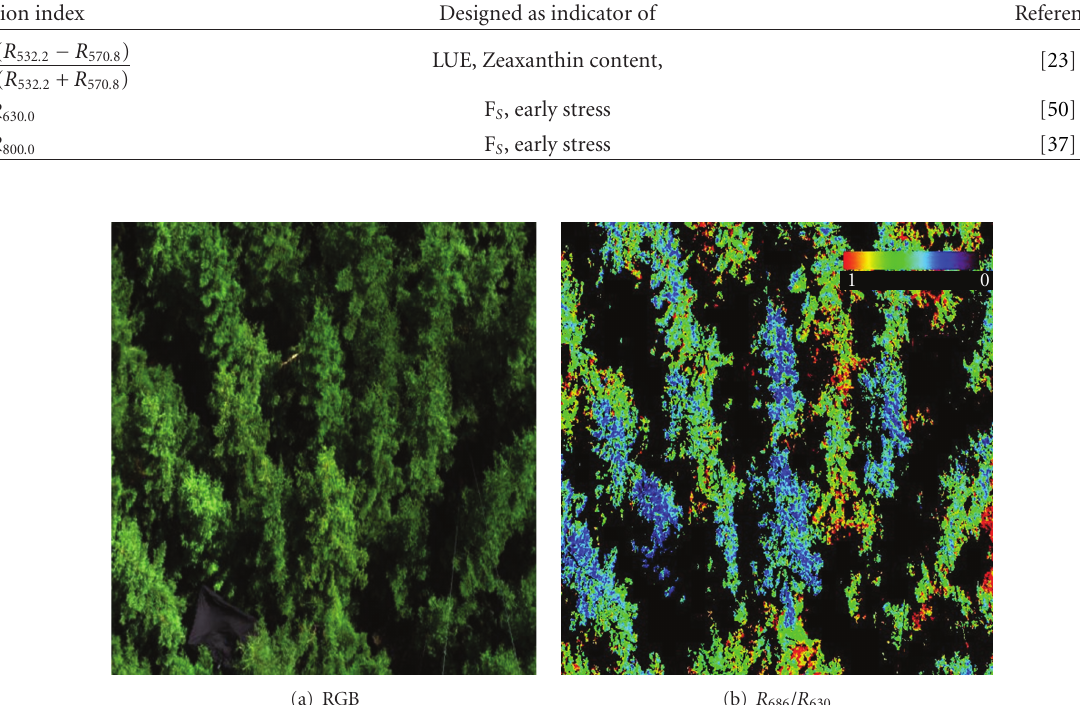
Figure 1: The image shows a true color red, green, and blue (RGB) composition of a Spruce forest measured in the Beskids Mountains acquired on 2nd September of 2005 at 10:00 A.M. (a) The same image was converted into the reflectance ratio R 686 / R 630 where the pixels in the shadow and with nongreen vegetation are excluded from the image and further analysis